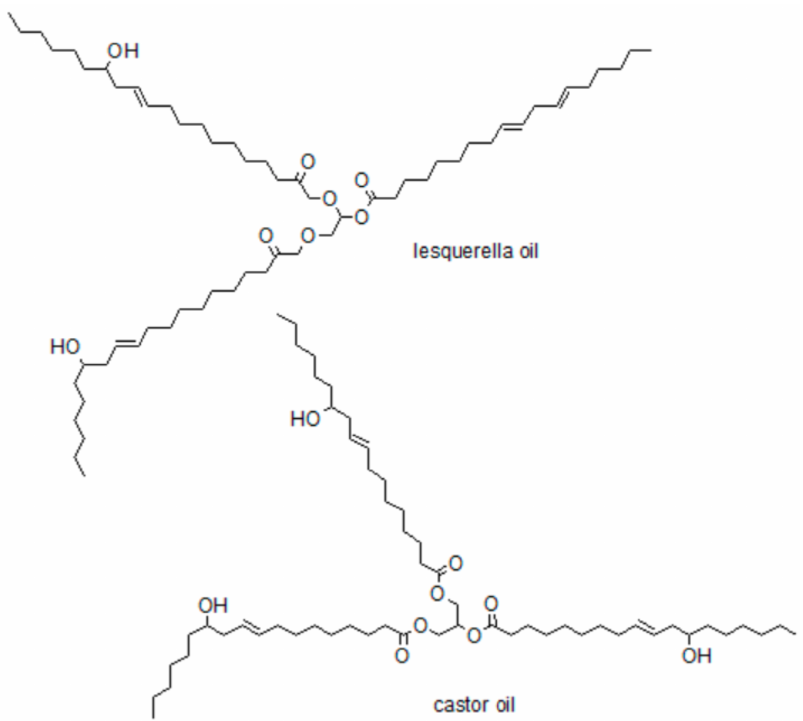
Figure 6. Scheme of lesquerella and castor